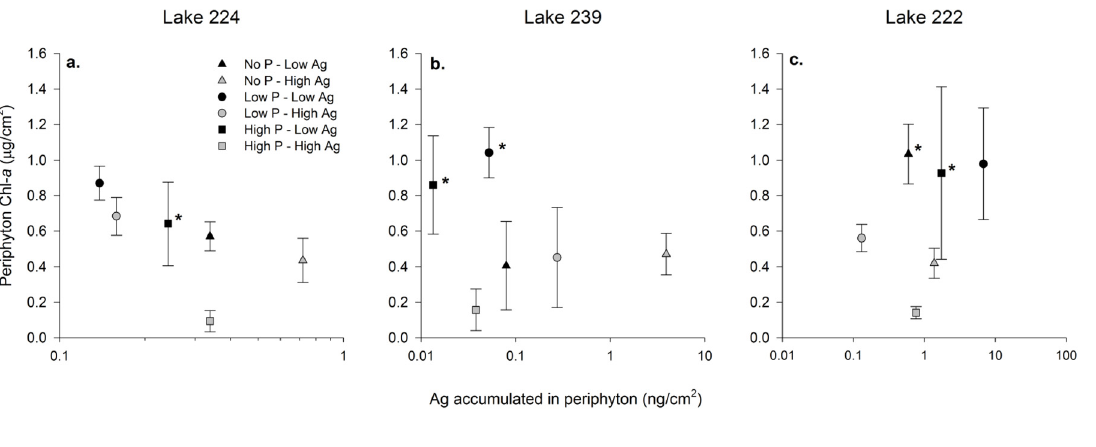
Fig 2. Relationship between background-corrected periphyton Ag and Chl- a . Background-corrected periphyton Ag was calculated as Ag content in treatments with AgNPs added — Ag in No-Ag treatment from the same P treatments in L224 (a), L239 (b), and L222 (c). Different symbols represent P treatments with Low-Ag treatments shown as filled symbols and High-Ag treatments shown as shaded symbols. Asterisks indicate low Low-Ag treatments that are significantly different than the corresponding High-Ag treatments with in the same P treatment. Error bars around symbols are standard deviations. Note the log scale for the